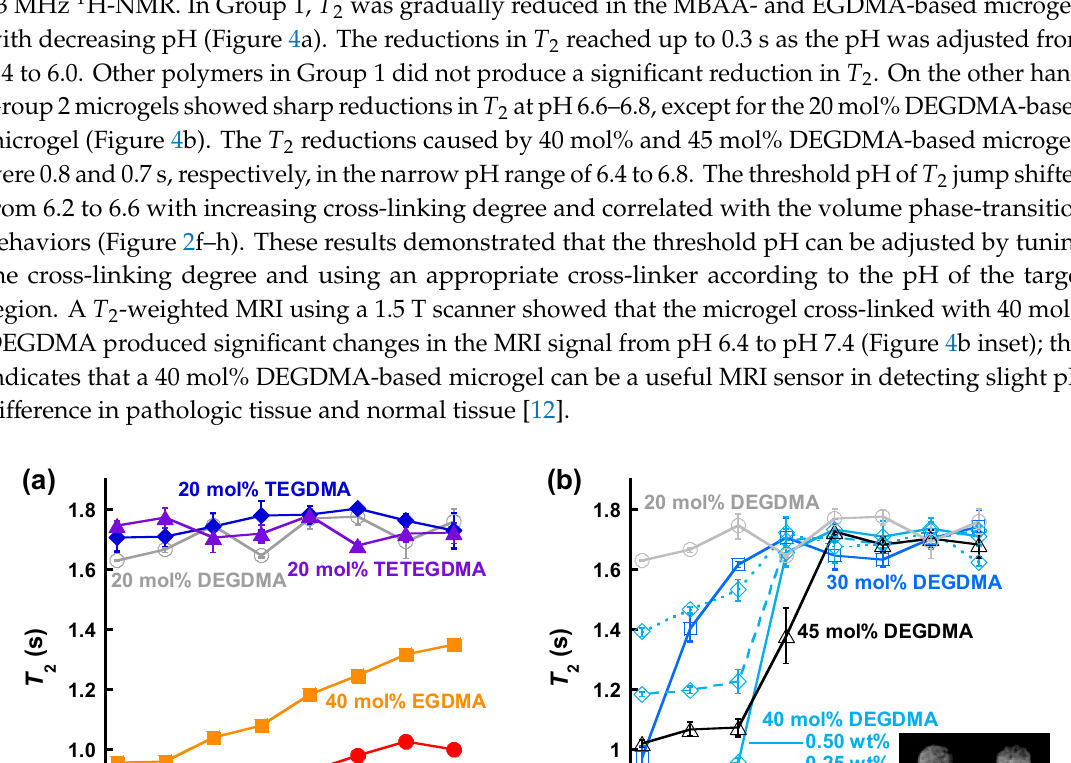
Figure 4. Transverse relaxation time ( T 2 ) of microgel suspensions of ( a ) Group 1 and ( b ) Group 2 in the pH range of 6.0–7.4 at 28 °C (mean ± standard error of the mean (SEM), n = 3). The microgel cross-linked with 20 mol% DEGDMA is shown in both figures. The inset in ( b ) is a T 2 -weighted image of the 40 mol% DEGDMA-based microgel in 100 mM phosphate buffer (pH 6.4 and 7.4) at room temperature. [microgel] = 0.50 wt% unless otherwise noted.